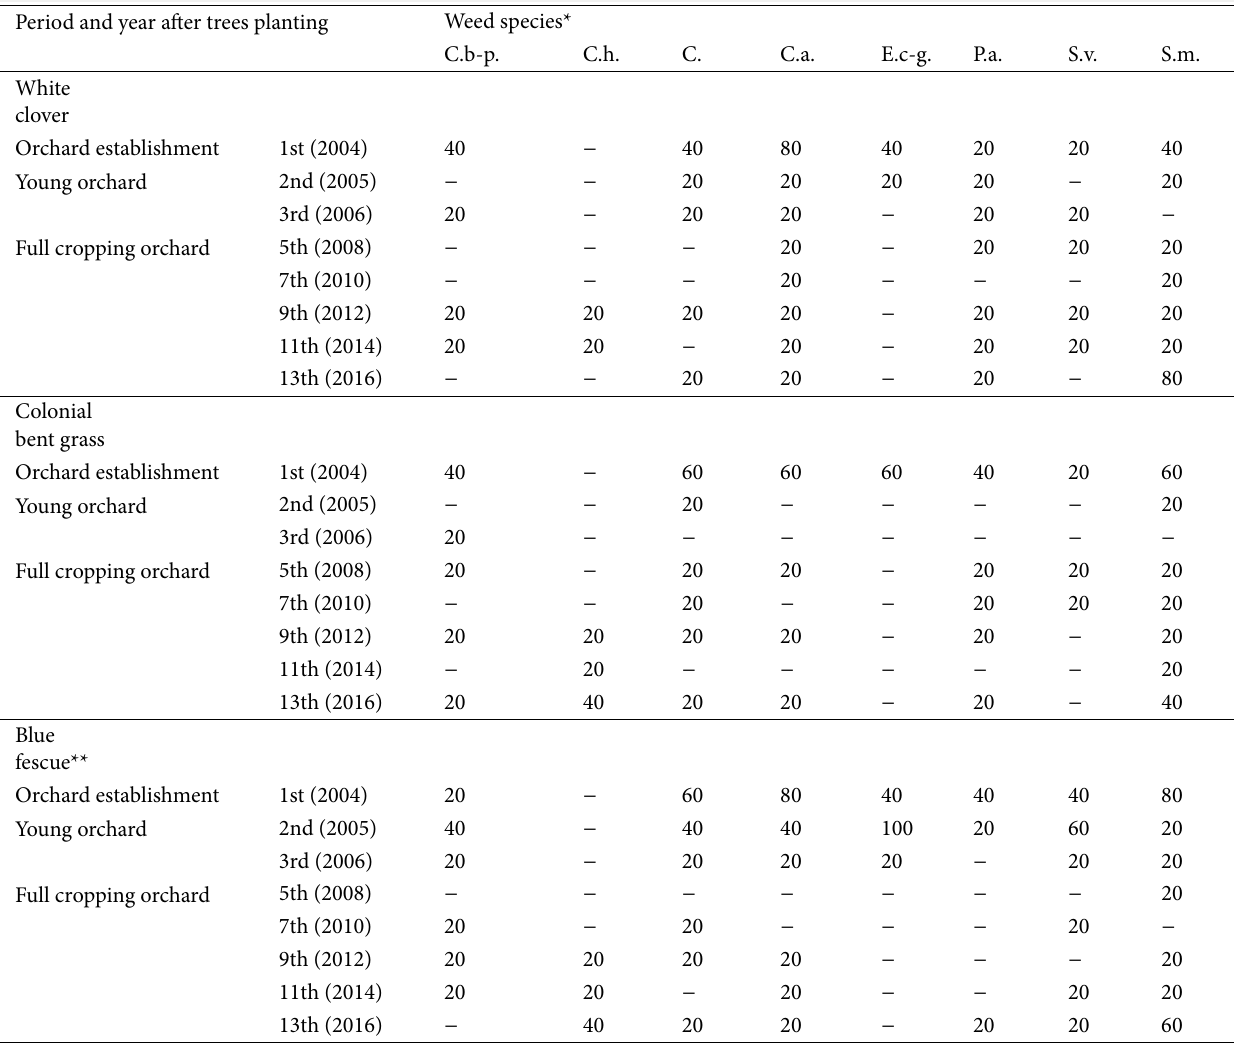
Table 4 Change in the mean percentage of the soil surface under the most important annual weed cover in the tree rows with the living mulch sod, in the succeeding years 2004 −